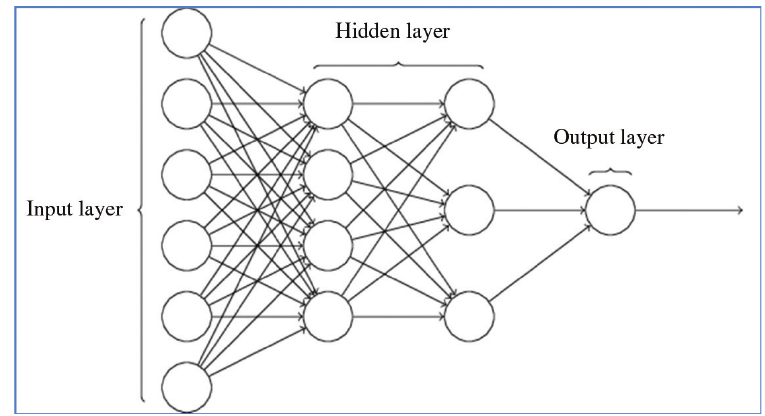
Figure 2: An Example of the Multilayer Perceptron Neural